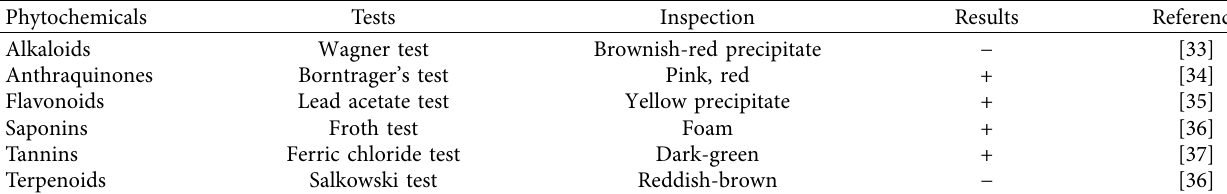
Table 3: Phytochemical screening of A. elegans leaf gel.